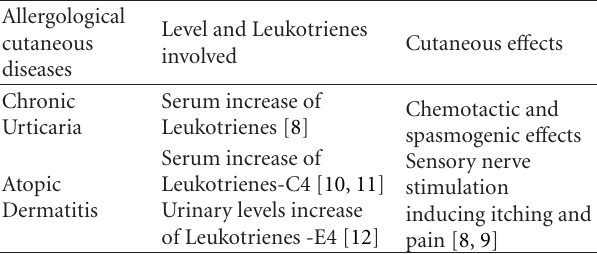
Table 1: Role of Leukotrienes in allergological cutaneous diseases.